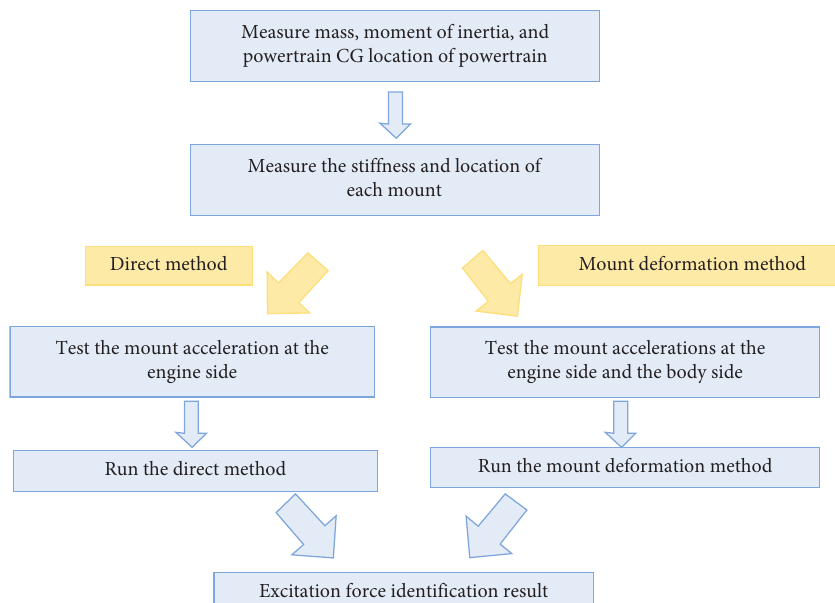
Figure 2: The identification flowchart of the two methods.